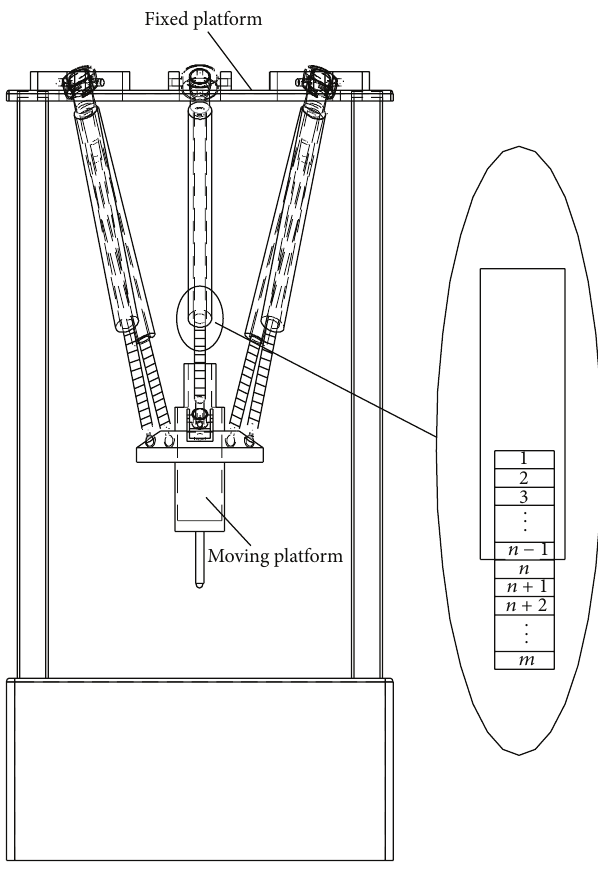
Figure 3: Figure of the finite element model of each driving limb.